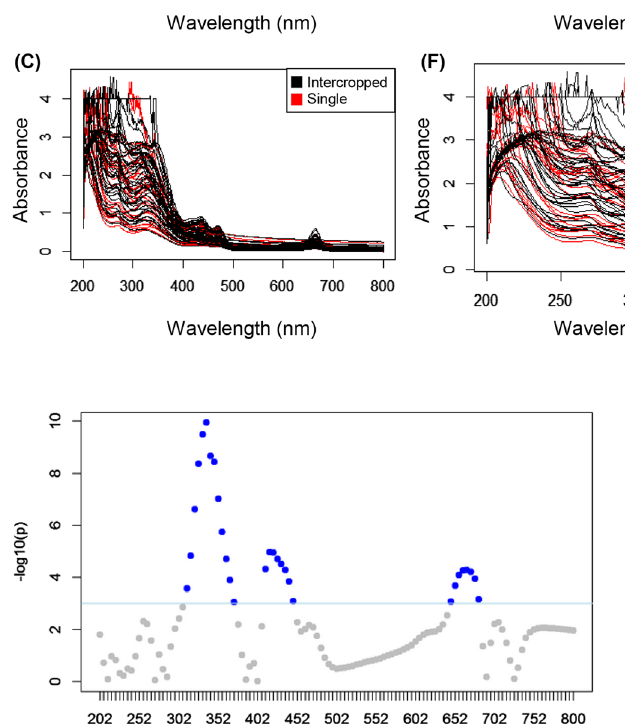
Figure 1: UV–vis spectra pro-